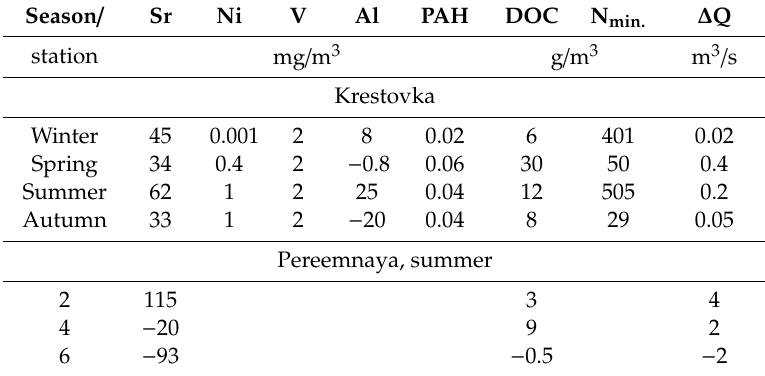
Table 8. Values of contaminant removal capacity of small tributaries of Lake Baikal, and ∆ Q